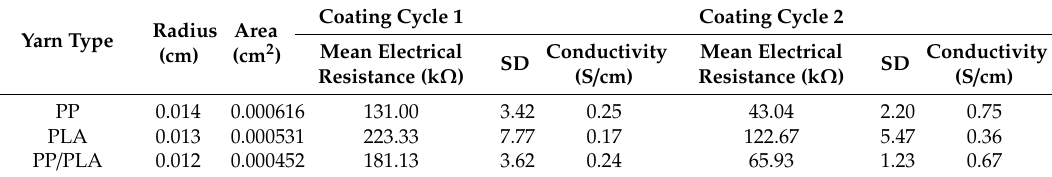
Table 2. Electrical conductivity (S / cm) of PEDOT:PSS coated PP, PLA, and blend PP / PLA yarn before rinsing.